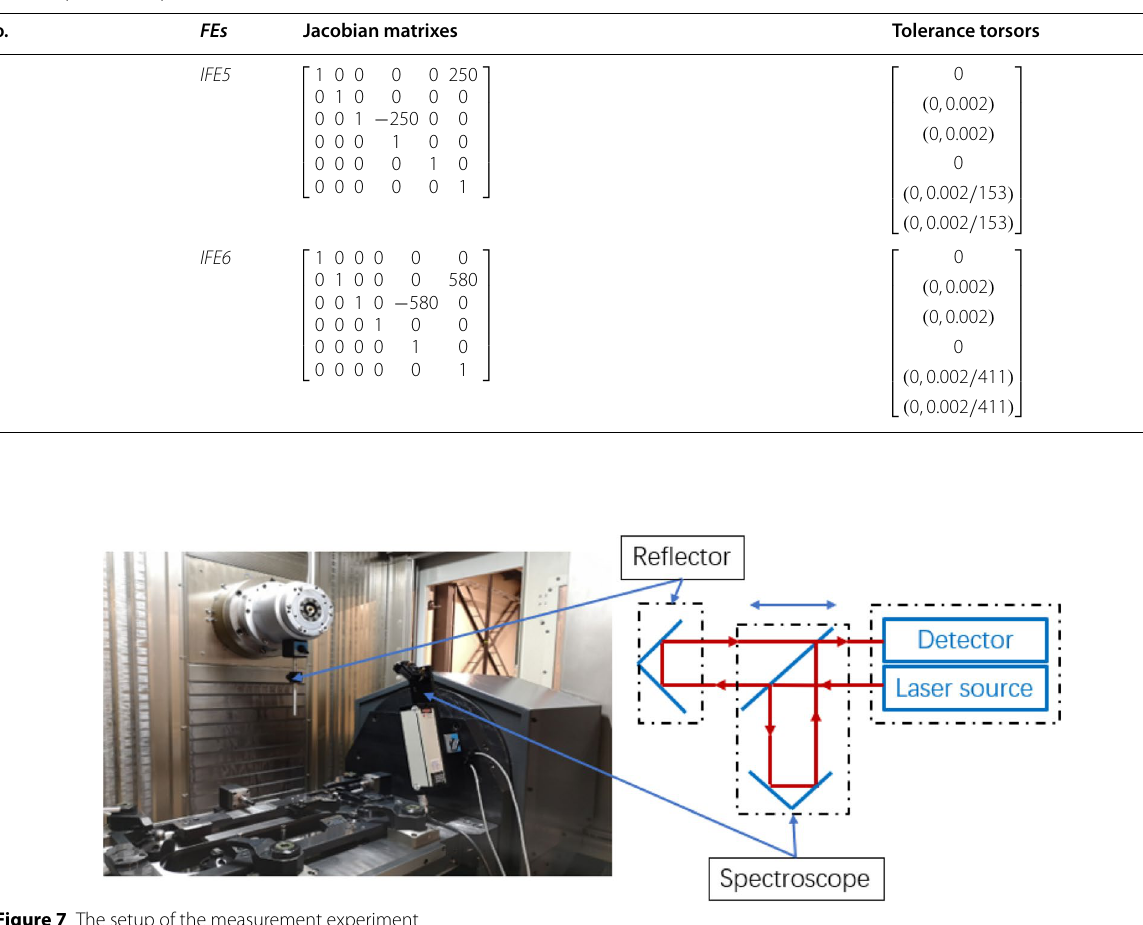
Figure 7 The setup of the measurement experiment